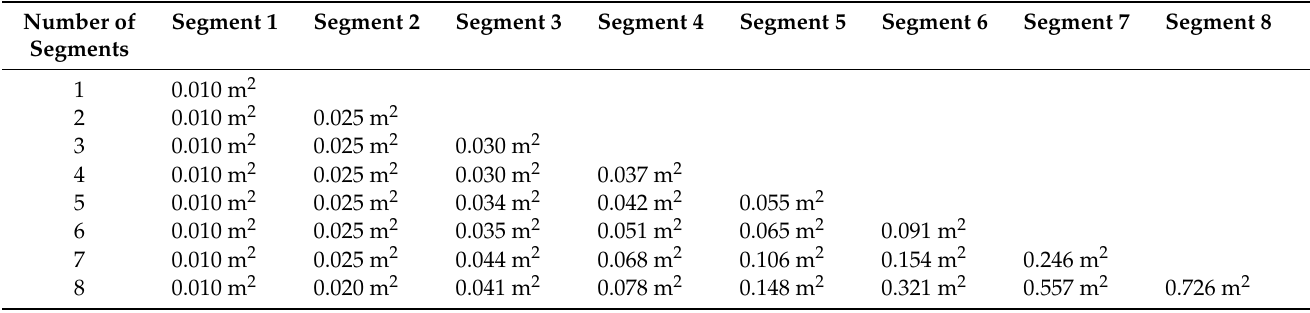
Table 6. Optimization results of sectional cross-sectional area of segmented space elevator system.